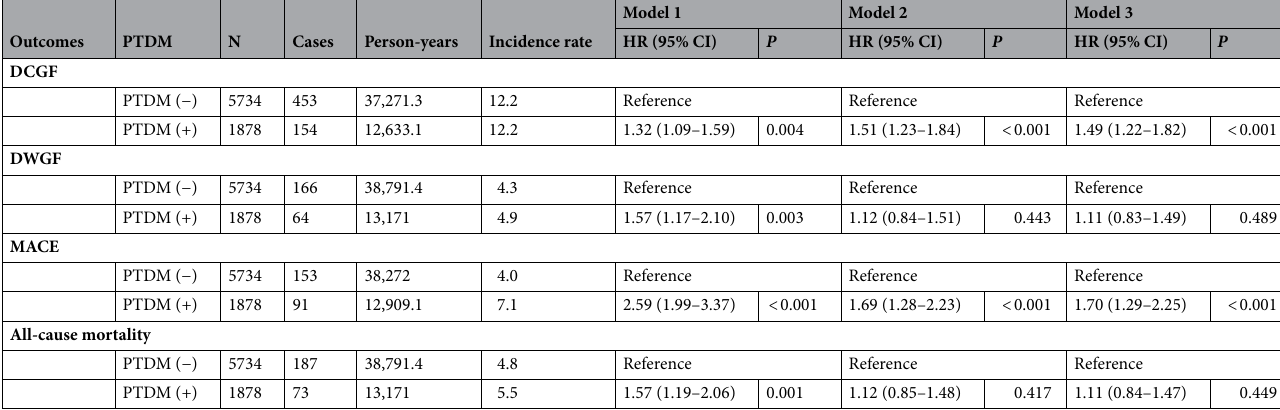
Table 2. Incidence rate and hazard ratio of adverse outcomes according to PTDM. Model 1: Univariate analysis. Model 2: Model 1 + adjustment with age, sex, history of hypertension, dyslipidemia, and cardiovascular disease, dialysis modality, duration of dialysis. Model 3: Model 2 + adjustment with induction therapy, desensitization, rejection, use of steroid. PTDM New onset diabetes after kidney transplantation, N